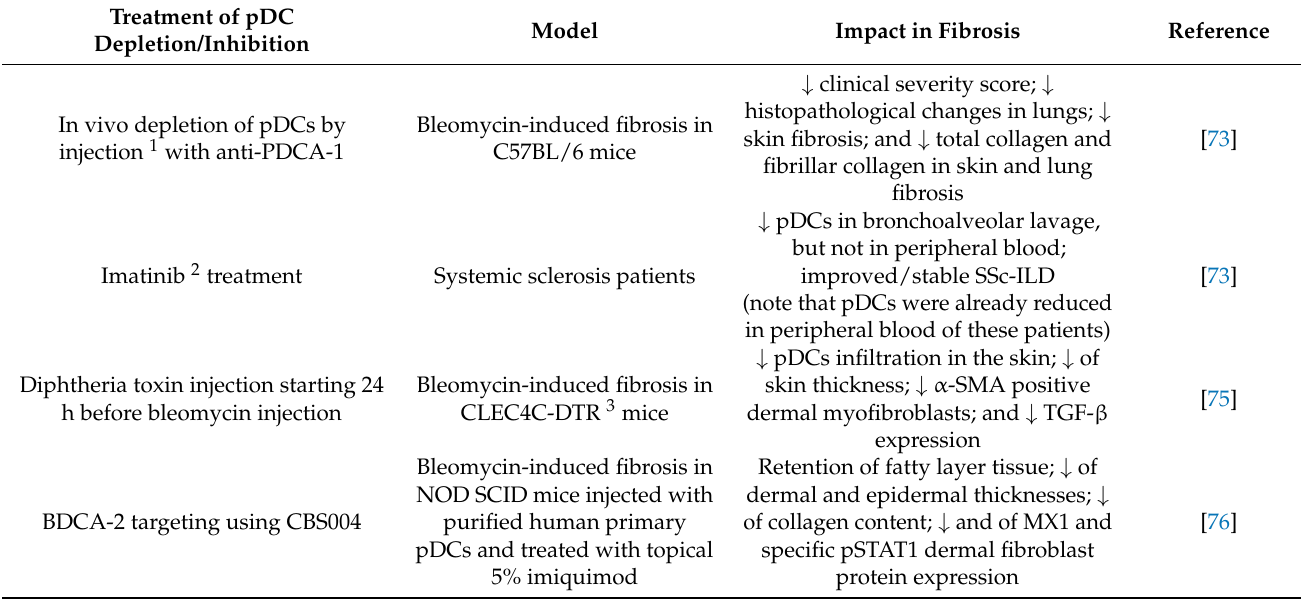
Table 1. Impact of pDC Depletion in Fibrosis. Summary of studies where pDCs have either been depleted or inhibited, and the effect in fibrosis was measured. Downward arrows ( ↓ ) indicate a